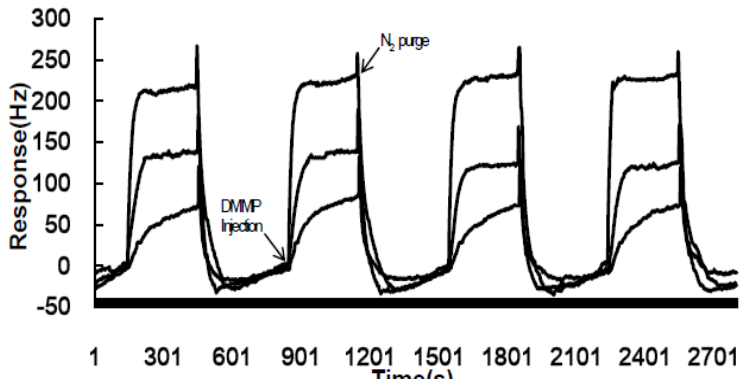
Figure 3. Response cycles of a QCM sensor coated with ZnO-modified NW-structured film towards 0.35, 0.70 and 1.75 ppms DMMP purged by high-purity nitrogen gas at MnO 2 room